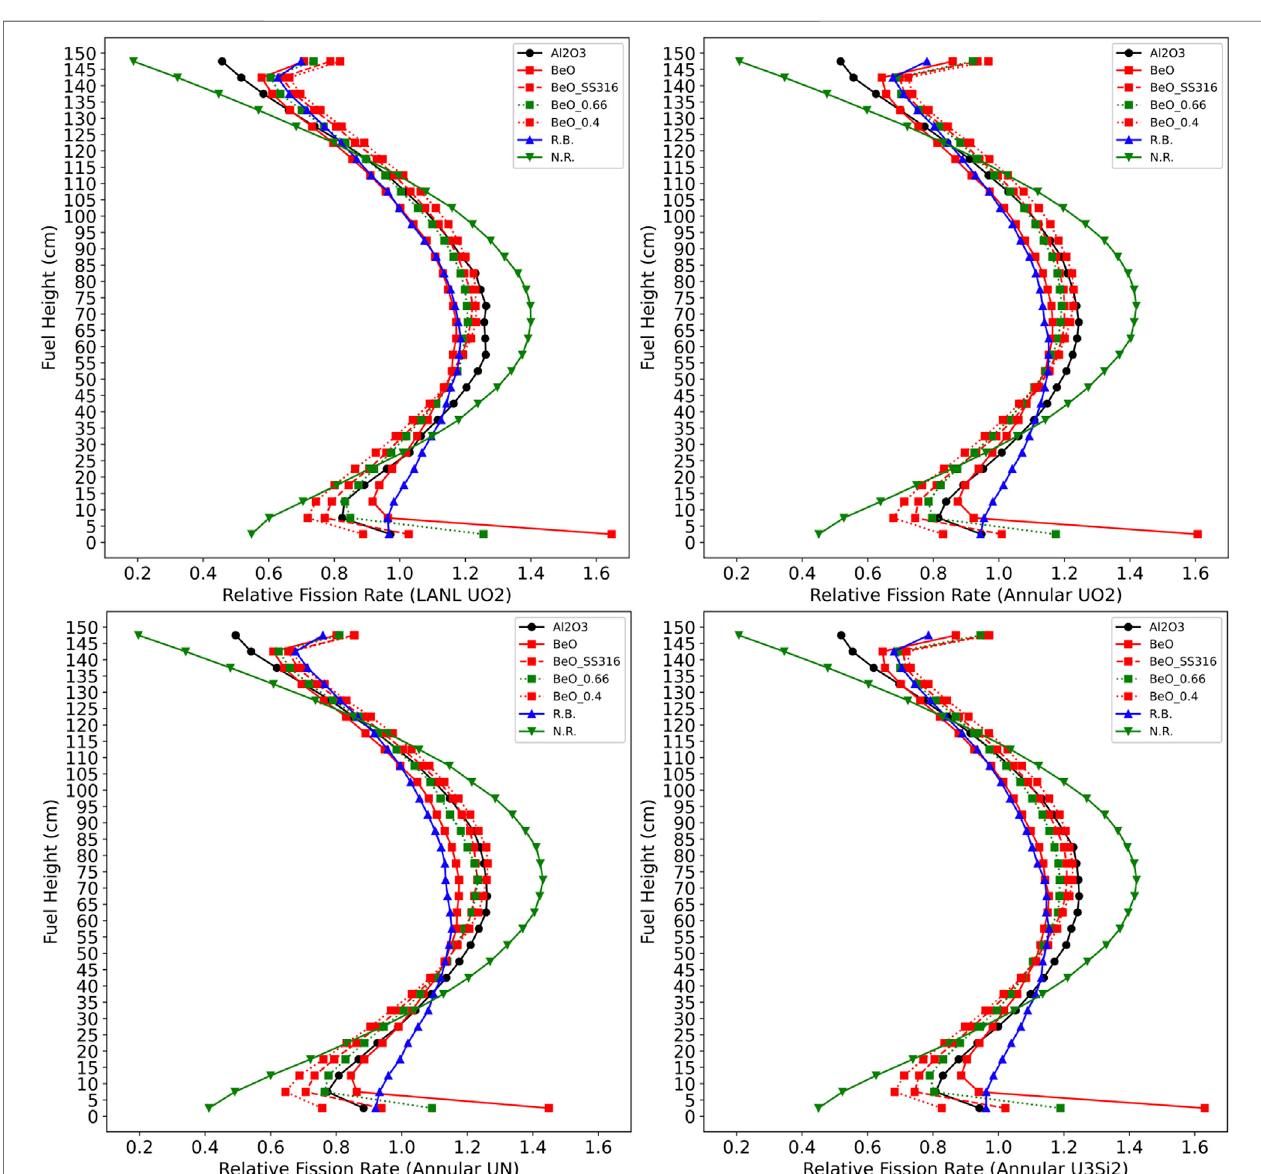
FIGURE4| The axialpower distribution at theBOLwithdifferentaxialre fl ectorconditions foreach design. BeO_SS316meansadding a2 cmSS316 betweenthe fuel and the bottom re fl ector, BeO_0.66 means that the BeO in the bottom re fl ector dwindles to 66.67%, BeO_0.4 means that BeO in the bottom re fl ector dwindles to 40%, R.B. denotes re fl ective boundaries condition, and N.R. denotes no re fl ector. The temperature is 900 K.